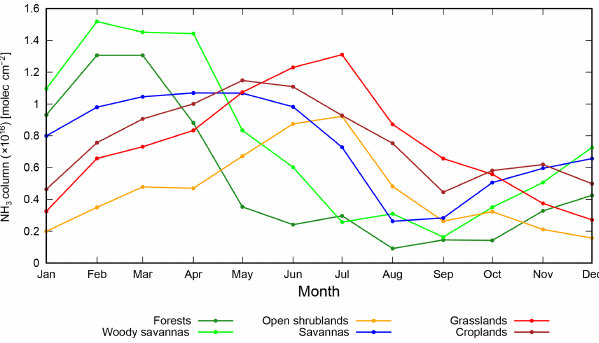
Figure 11. Monthly variations of ammonia column amount from GOSAT for the study period over forests, woody savannas, open shrublands, savannas, grasslands, and croplands classified by the MODIS product in